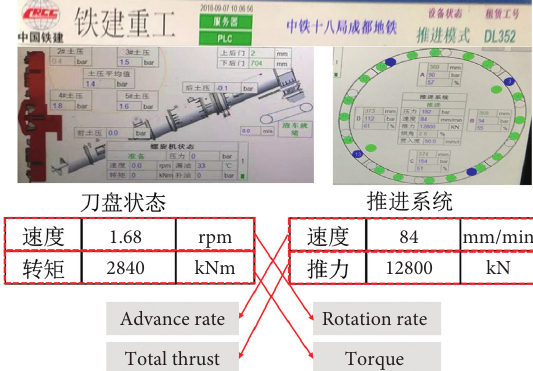
Figure 5: Main operational parameters displayed on the dashboard.